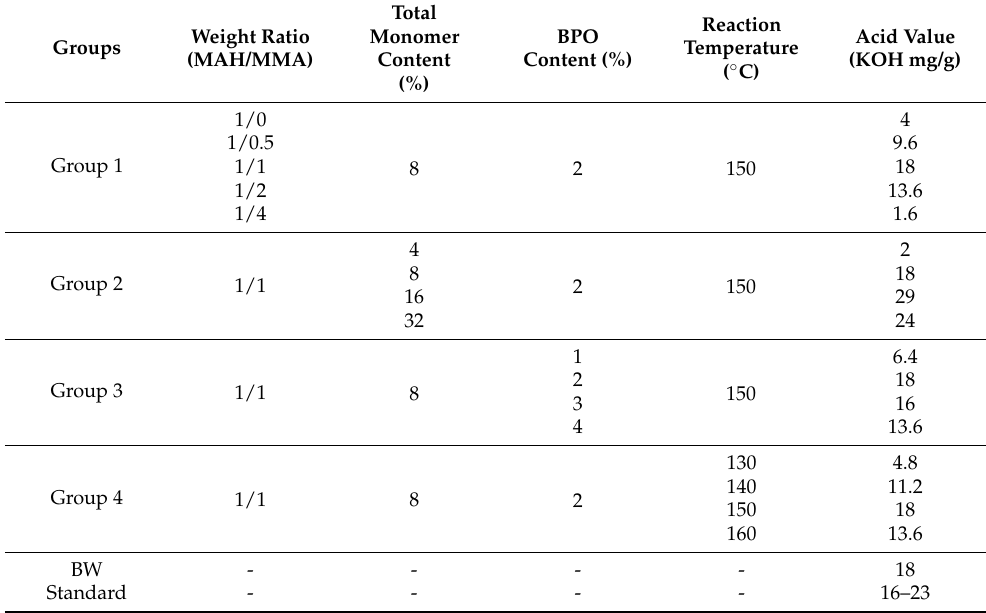
Table 2. Test results of acid value of BW and PEW- g -MAH-MMA with different grafting conditions.